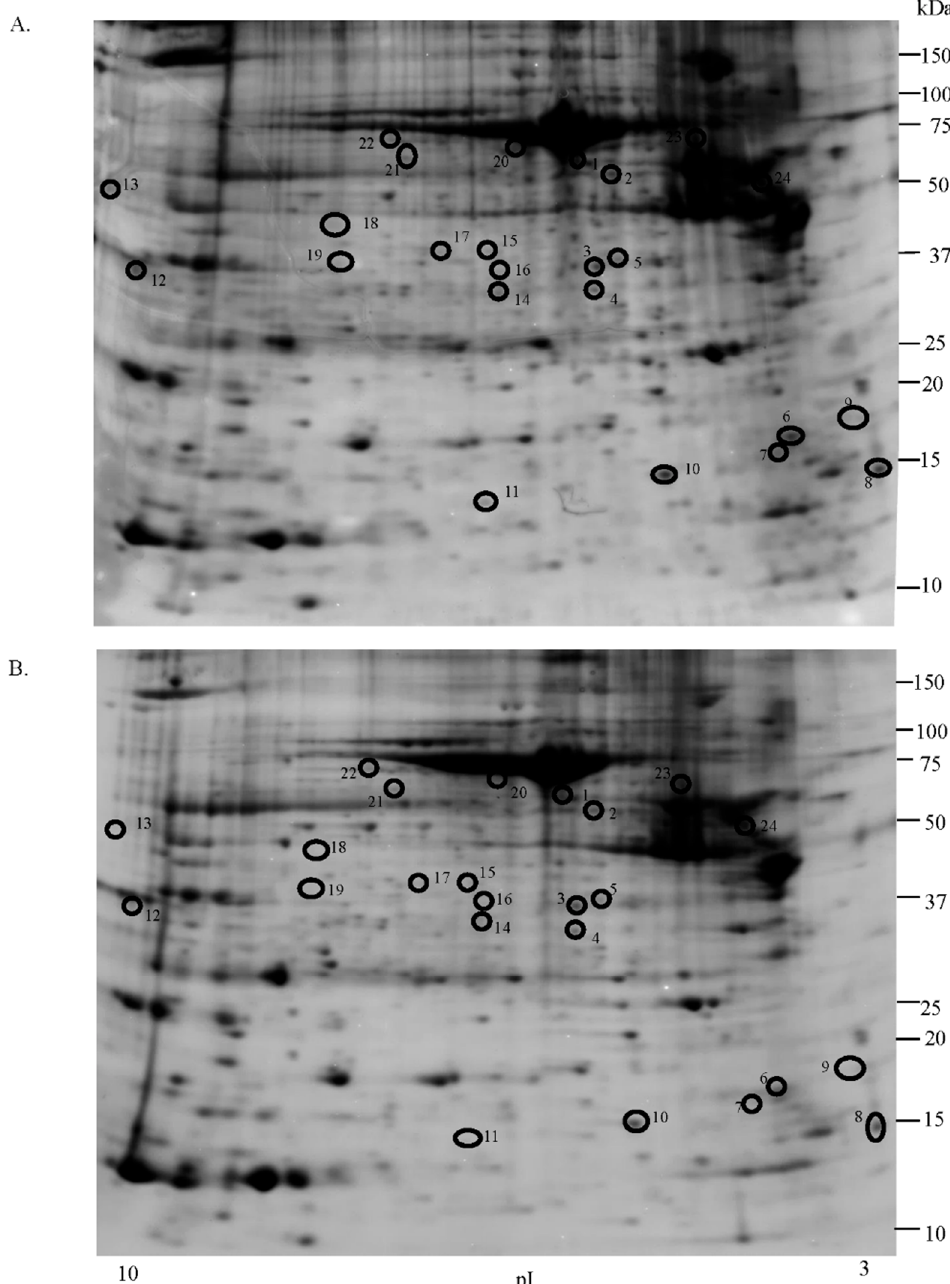
Figure 1. Two-dimensional electrophoresis map of uterine leiomyoma ( A ) and normal myometrium ( B ) proteome. Black circles indicate up-regulated protein spots. Immobilized pH gradient 3–10 NL strips were used for the first dimension, and 12.5% polyacrylamide gel was used for the second dimension.